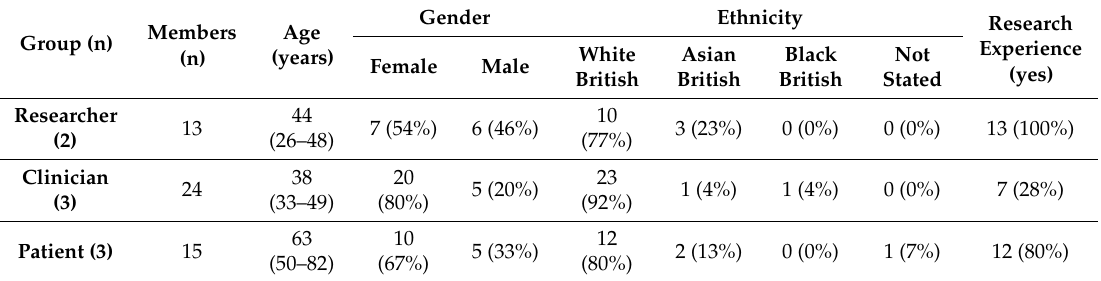
Table 3. Characteristics of members of initial discussion groups. Median and IQR (interquartile range) are reported for